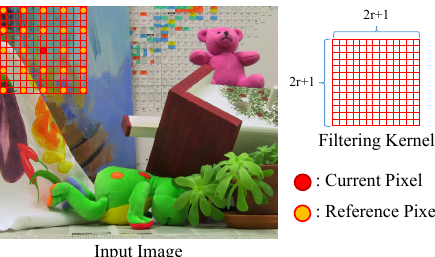
Figure 1. Example of kernel subsampling. Only samples of current (red) and reference (yellow) pixels are